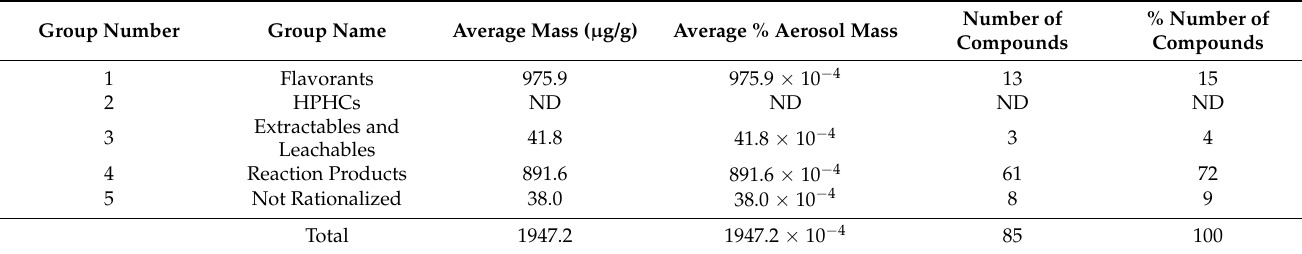
Table 9. Summary of Non-Targeted Analyses in VT5 Aerosol Using the Intense Puffing Regimen.